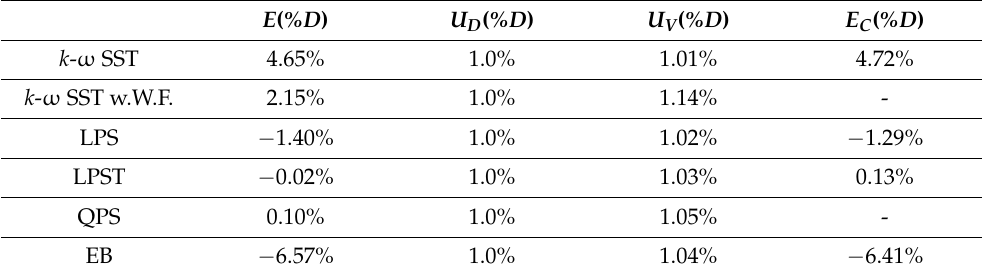
Table 5. Results of the validation for each turbulence